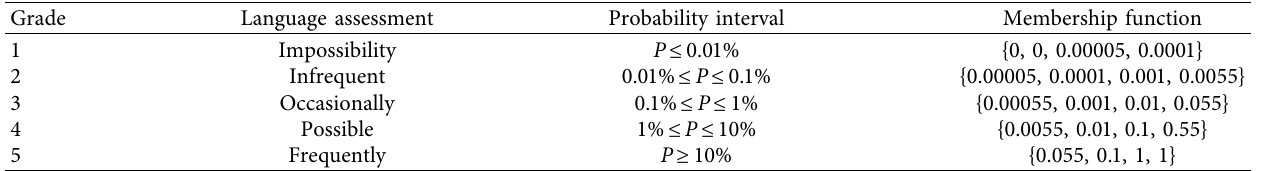
Table 3: Corresponding relation between risk occurrence probability grade standard and membership function.